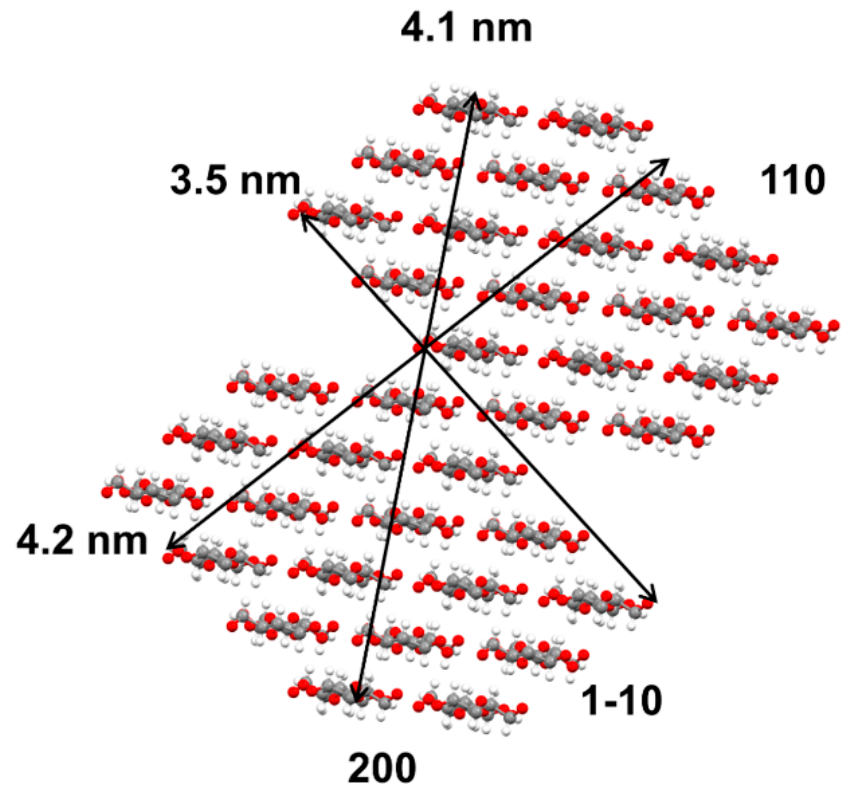
Figure 5. Cross-section model of cellulose crystallite for softwood fibers and hardwood fibers.